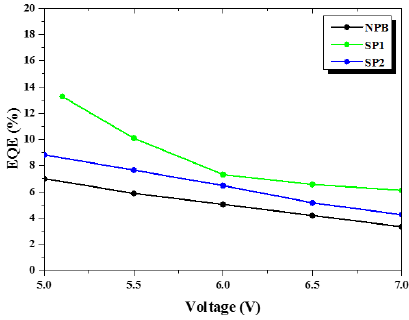
Figure 9. External quantum efficiencies of 4,4′-bis( N -phenyl-1-naphthylamino)biphenyl (NPB)-, diphenylacridine (SP1)-, and phenothiazine (SP2)-based devices.